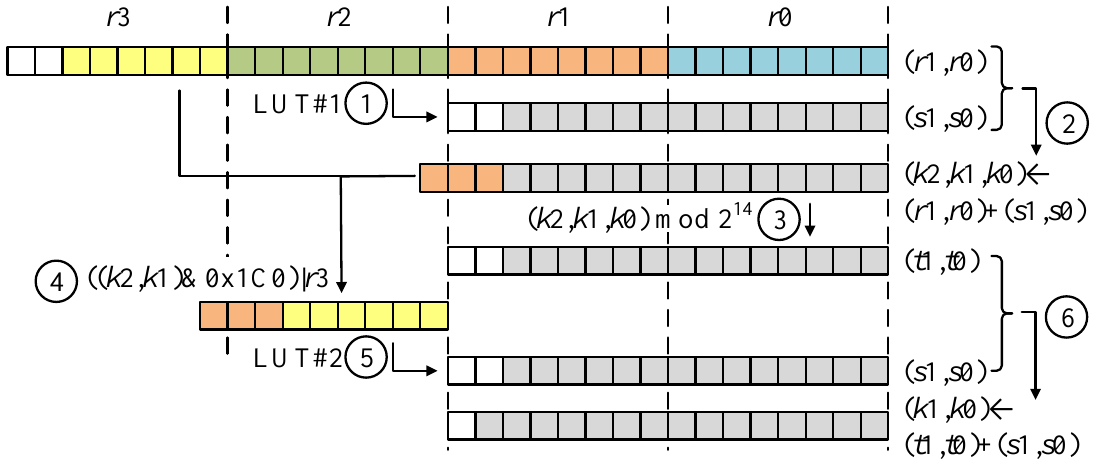
Figure 2. Look-Up Table-based Fast Reduction for q = 12,289, 1 (cid:13) : LUT access; 2 (cid:13) : addition; 3 (cid:13) :